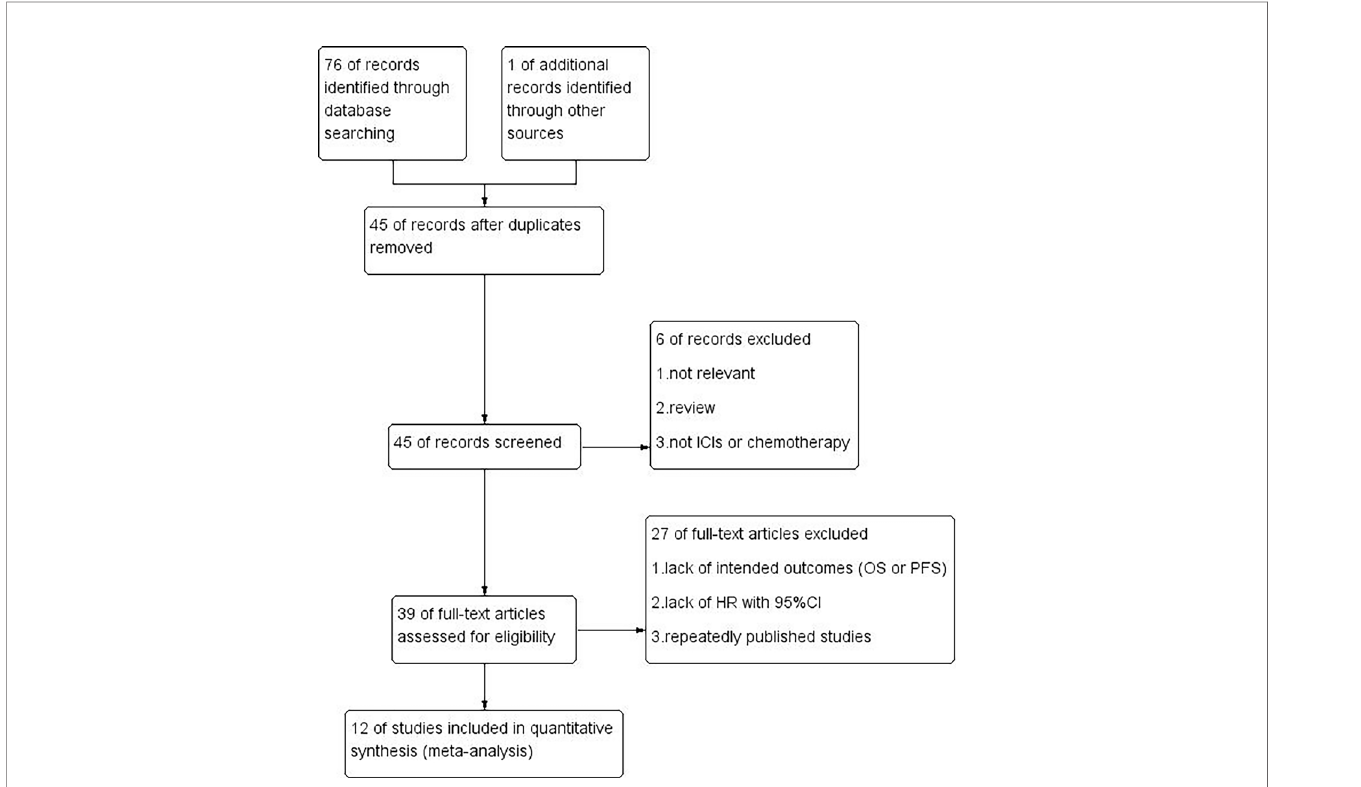
FIGURE 1 | Flow diagram of study